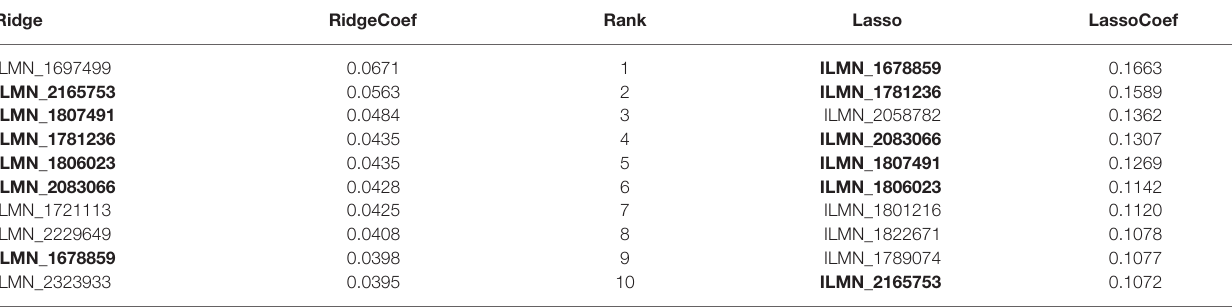
TABLE 2 | The top-10 features ranked by the model coefficients of the regression models Ridge and Lasso. Ridge RidgeCoef Rank Lasso